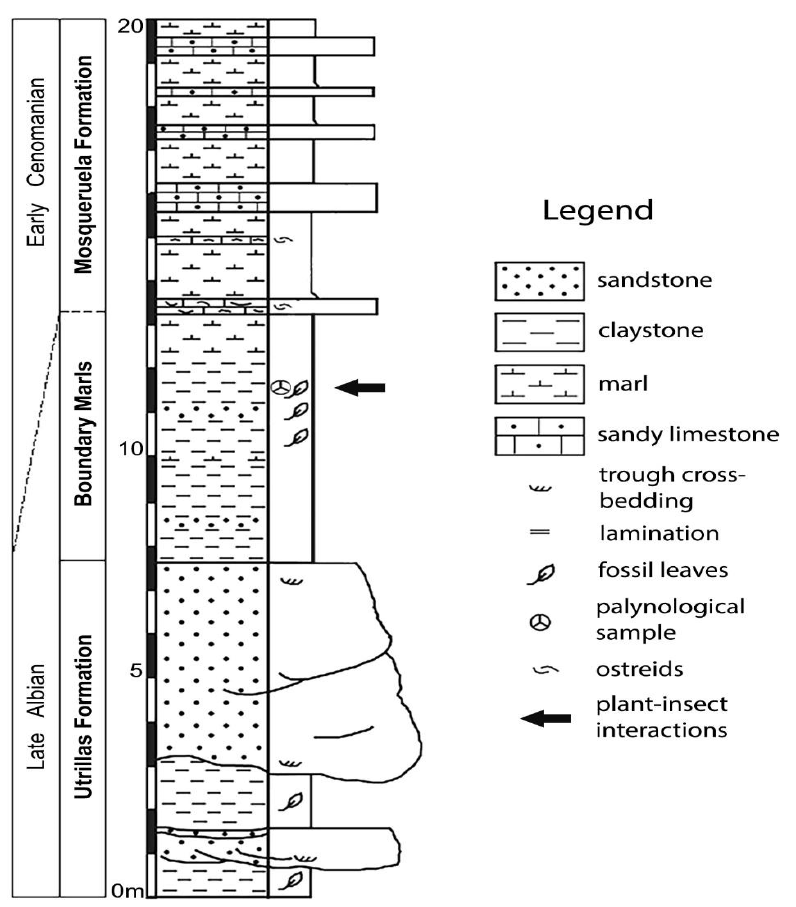
Figure 2. Stratigraphic section of the latest Albian “La Dehesa” fossil site in Estercuel locality (Spain) bearing the studied interactions (modified from